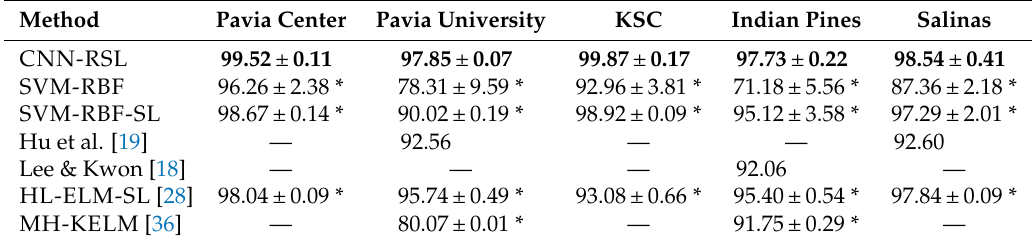
Table 9. Test set classification accuracy when using 200 randomly sampled labeled pixels per class for training. We report the mean and standard deviation over 10 runs. The best accuracy for each dataset is indicated in bold. With the exception of methods from [18,19], an ‘*’ means that the best accuracy is significantly better than the accuracy achieved by the corresponding method according to a binomial test for comparing classifiers [45] ( p -value < 0.05).